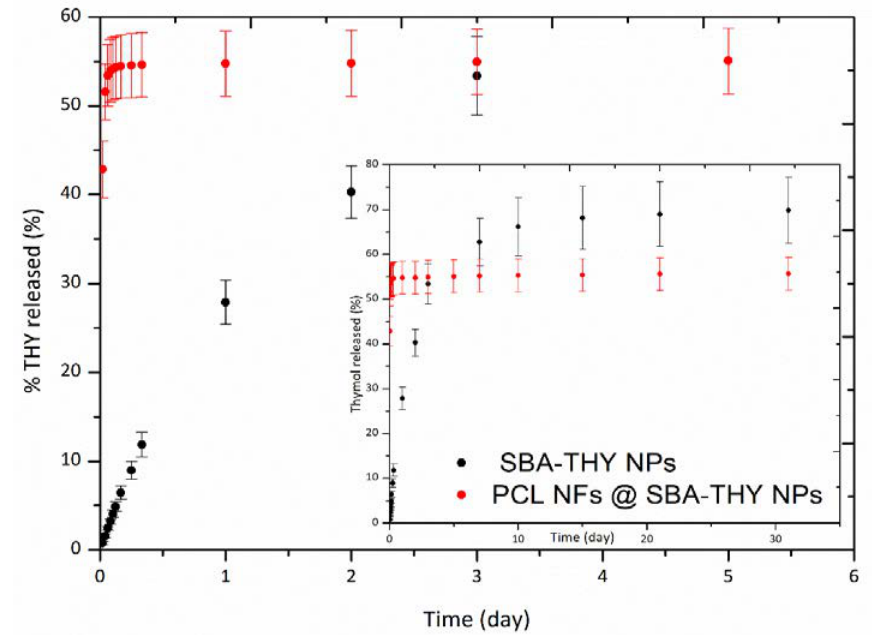
Figure 4. Release profile of THY form SBA-THY NPs and PCL NFs@SBA-THY NPs.